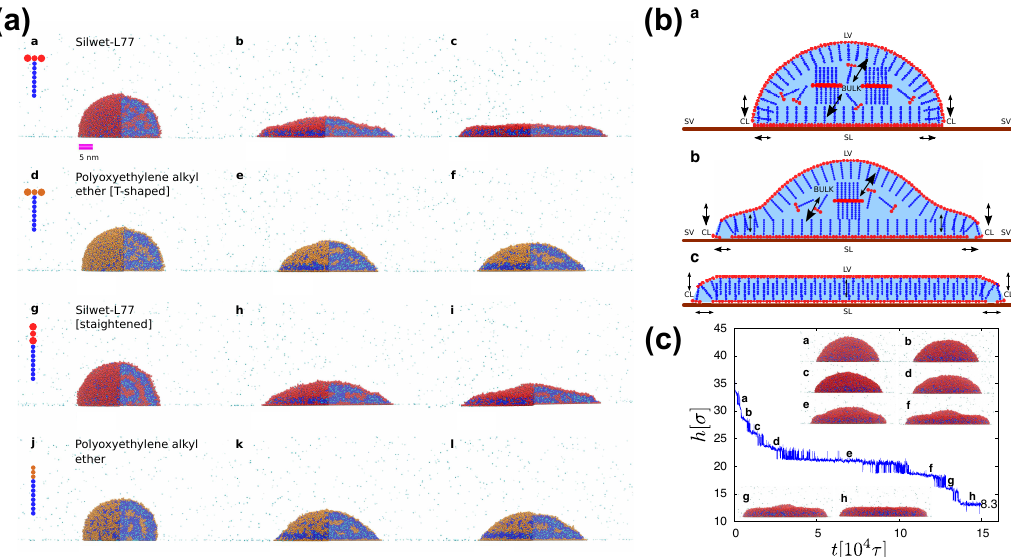
Figure 8. Results from the SAFT CG model. ( a ) Time evolution of the spreading process for superspreading and nonsuperspreading surfactants at times 0 τ , 7 × 10 4 τ , and 14 × 10 4 τ . Hydrophobic beads are in orange or red and hydrophilic beads are in blue. Cyan beads indicate the water molecules with each bead corresponding to two water molecules. Reprinted from Ref. [20]. Copyright 2015 American Chemical Society; ( b ) Schematic illustration of the leading adsorption processes during superspreading. The dominant direction of the adsorption is illustrated with a larger arrow end. The essential processes are the adsorption from the LV interface onto the substrate through the CL and the adsorption from the bulk to the LV interface. Reproduced from Ref. [19] with permission from The Royal Society of Chemistry. ( c ) The time evolution of droplet height during superspreading. Representative snapshots at each time are illustrated as indicated. Reproduced from Ref. [19] with permission from The Royal Society of